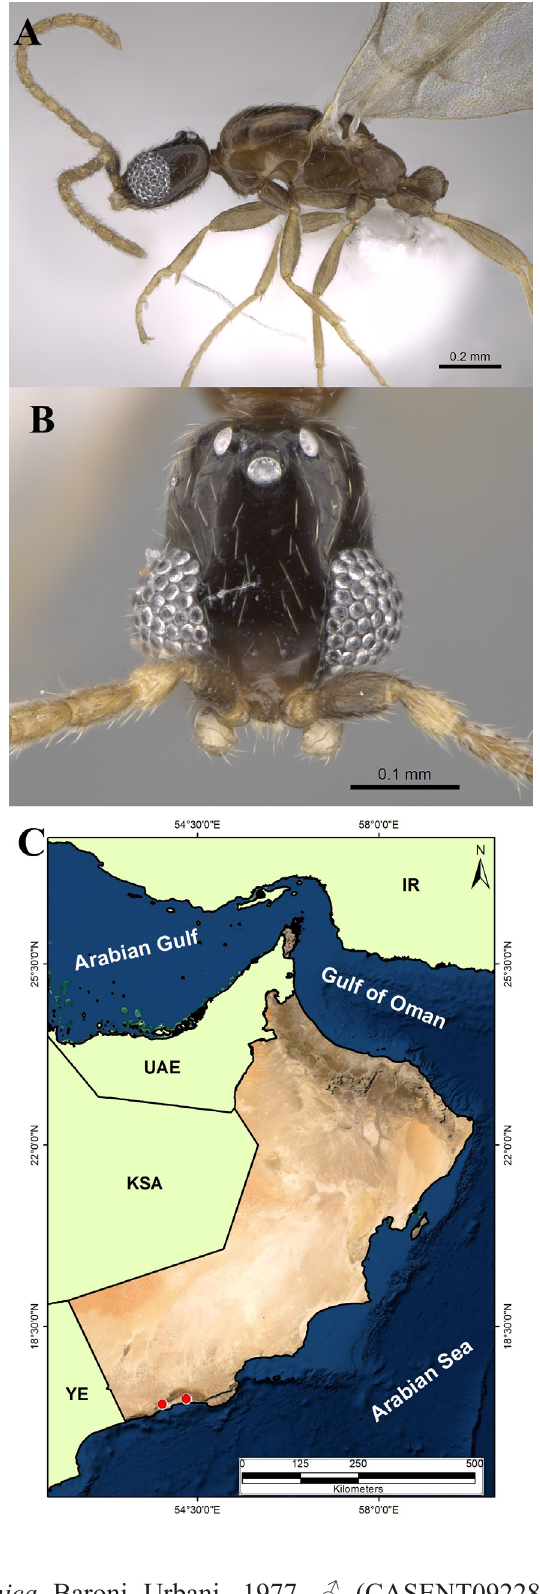
Fig. 25. Leptanilla islamica Baroni Urbani, 1977, ♂ (CASENT0922880, AntWeb.org (Michele Esposito)). A . Body in profile. B . Head in full-face view. C . Distribution